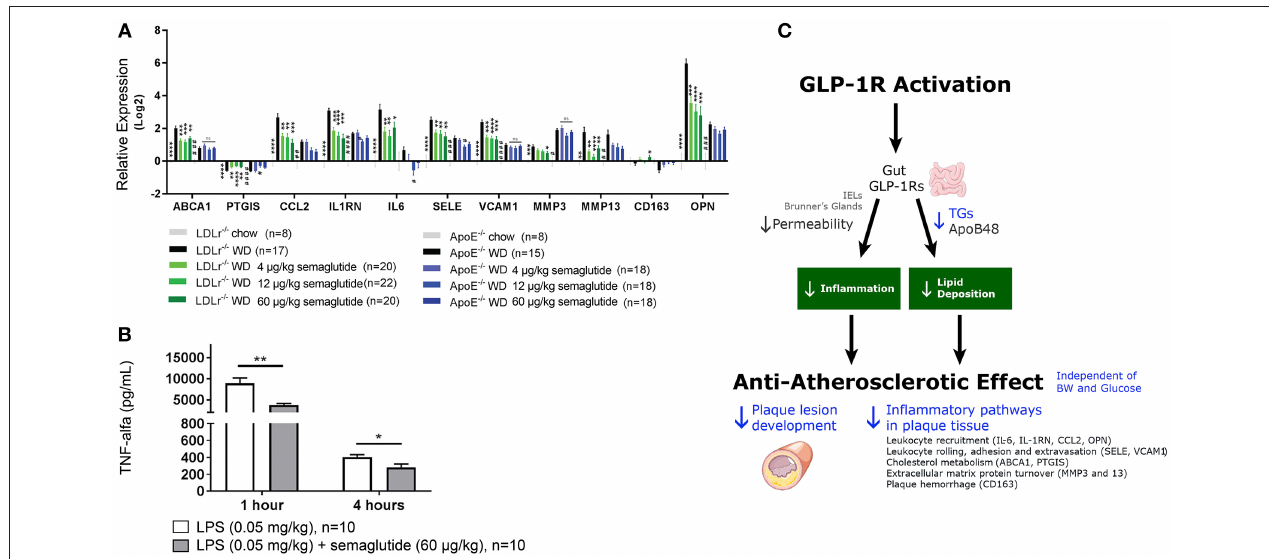
FIGURE 11 | Effects of GLP-1RAs on atherosclerosis is hypothesized to occur via inflammation. (A) Gene expression changes by WD and semaglutide (compared with vehicle-dosed chow-fed animals), exemplifying genes that represent pathways with well-described relevance to plaque formation and the pathophysiology of atherosclerosis, Benjamini–Hochberg corrected p -values; **** p < 0.0001; *** p < 0.001; ** p < 0.01; * p < 0.05 vs. LDLr − / − , WD; #### p < 0.0001, ### p < 0.001; ## p < 0.01; # p < 0.05 vs. ApoE − / − , WD. (B) Subcutaneous administration of semaglutide in an LPS inflammation model reduced plasma levels of TNF-alfa, ** p = 0.0024 vs. vehicle at 1h and p = 0.048 vs. vehicle at 4h. (C) Proposed model illustrating how long-acting GLP-1RAs could reduce atherosclerotic burden. ABCA 1, ATP-binding cassette transporter 1; ApoE, apolipoprotein E; BW, body weight; CCL2, chemokine [C-C motif] ligand 2; CD, cluster of differentiation; GLP-1RA, glucagon-like peptide-1 receptor agonist; IEL, intestinal intraepithelial lymphocyte; IL, interleukin; LDL, low-density lipoprotein; LPS, lipopolysaccharide; MMP, matrix metalloproteinase; OPN, osteopontin; PTGIS, prostaglandin I2 synthase; SELE, selectin E; TG, triglyceride; TNF-alfa, tumor necrosis factor-alfa; VCAM 1, vascular adhesion molecule 1; WD, Western diet. Reprinted from Rakipovski et al. (111), Copyright 2018, with permission from